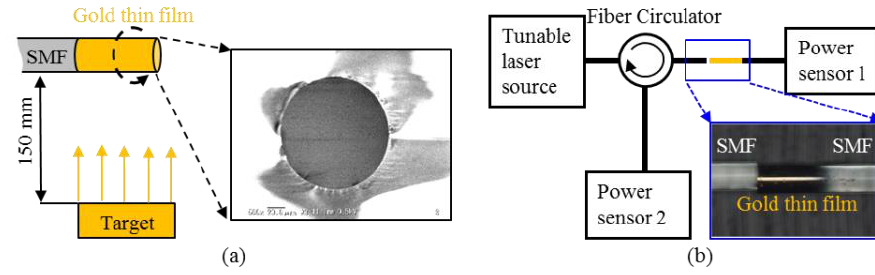
Figure 4. Production and evaluation of the gold thin films ( a ) scheme of sputtering system and SEM image of the fabricated gold thin film using sputtering process; ( b ) measurement system for the transmittance and reflectance of the gold thin film.